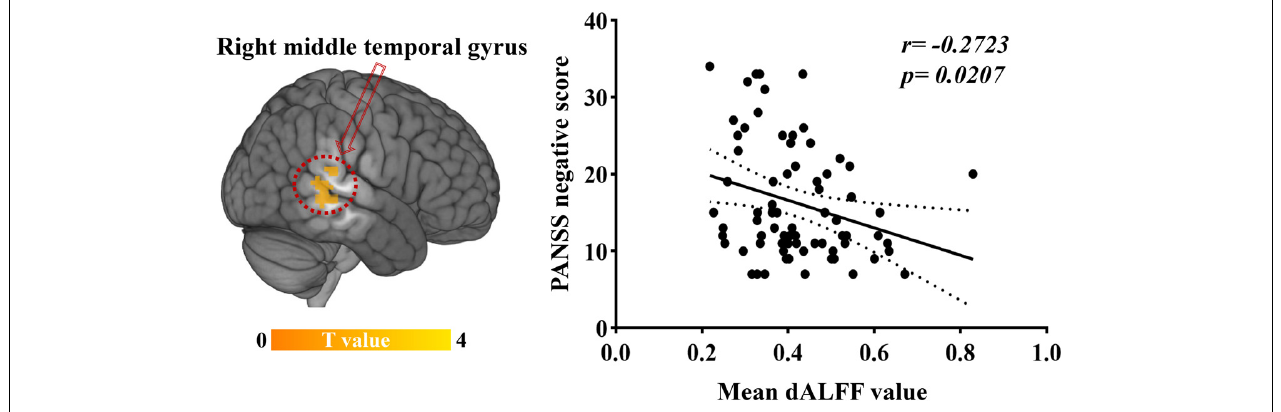
FIGURE 3 | Relationship between dALFF variability and clinical symptoms. Increased dALFF variability of the right MTG was negatively correlated with PANSS negative scores of patients with EOS ( p < 0.05,